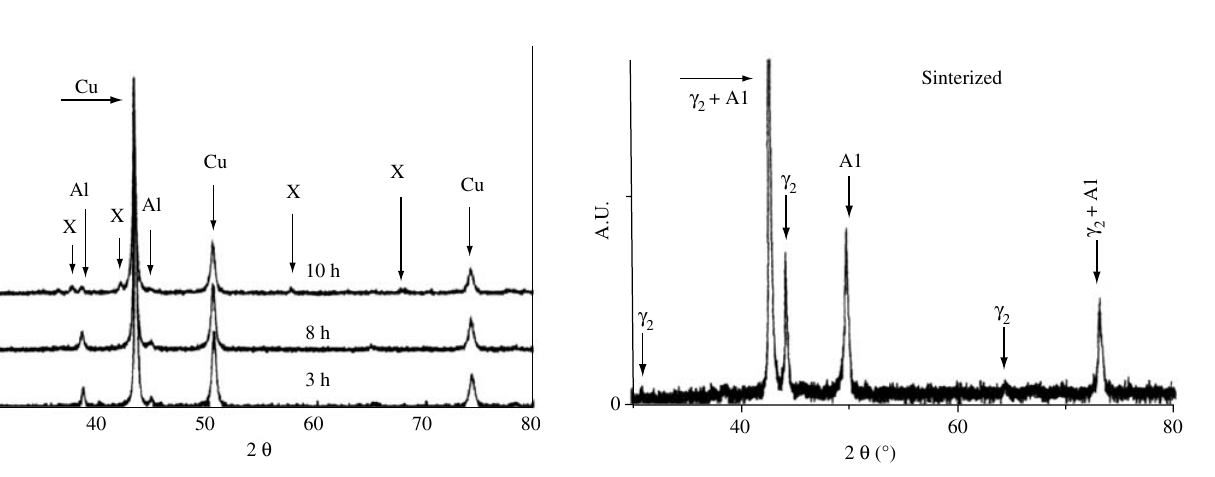
Figure 3. X-ray diffractogram of sintered Cu-13Al-2Nb